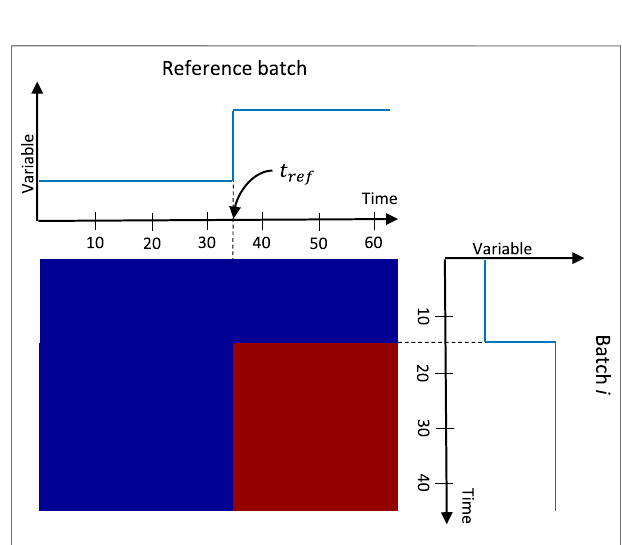
FIGURE 4 | Cross-correlation matrix for a step